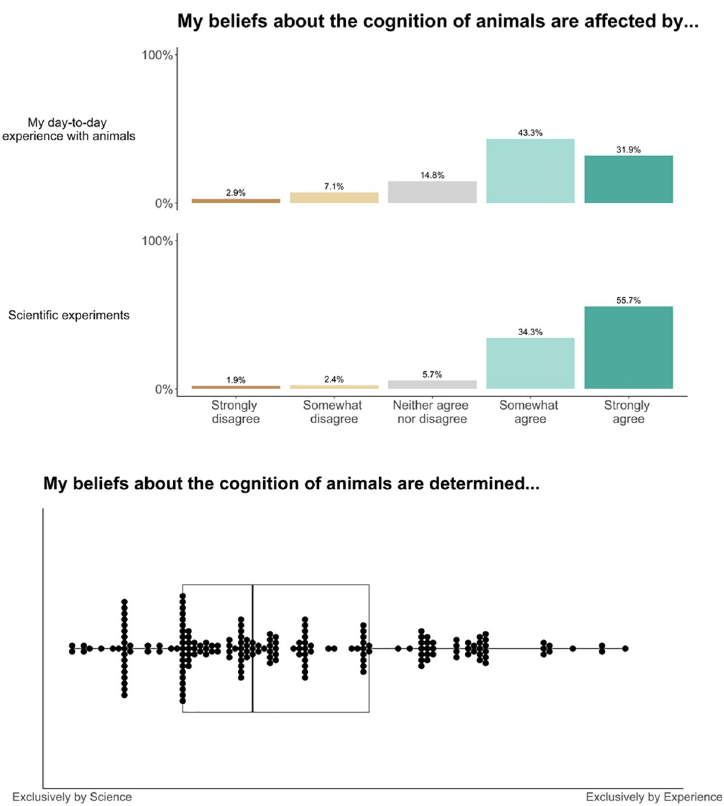
Fig 17. Animal cognition researchers’ reports of the role of science and daily experience in shaping their beliefs about animals’ cognition. N = 210. Top: Answers to individual questions on the role of experience and science. Bottom: Researchers’ responses about the relative role of science and experience. Each dot represents one researcher’s response. with boxplots showing the median and inter-quartile ranges laid